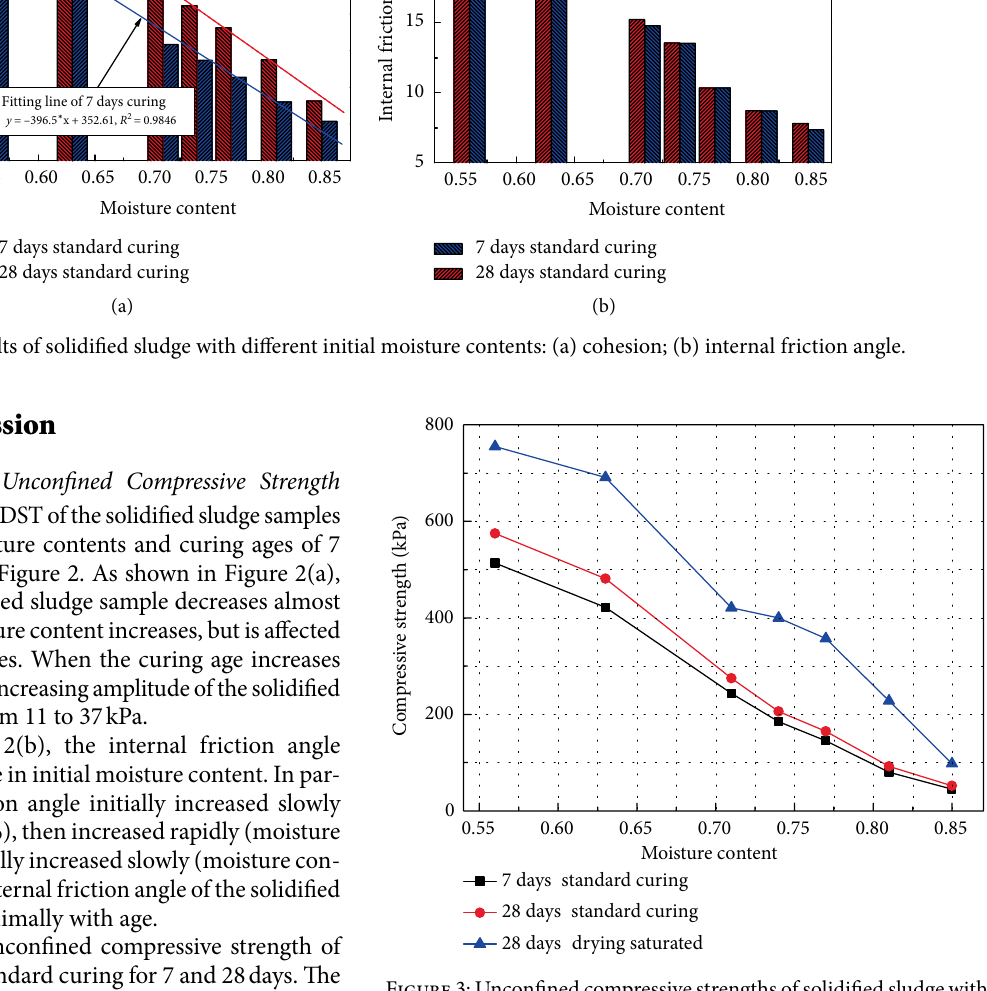
Figure 3: Unconfined compressive strengths of solidified sludge with different initial moisture